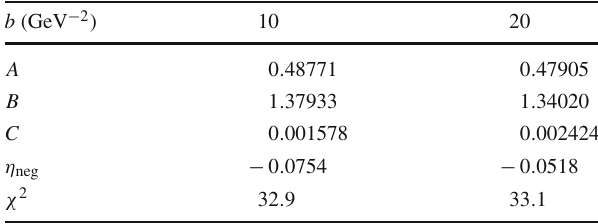
Table 1 Results of the ABC fit to 51 data points with x < 0 . 001